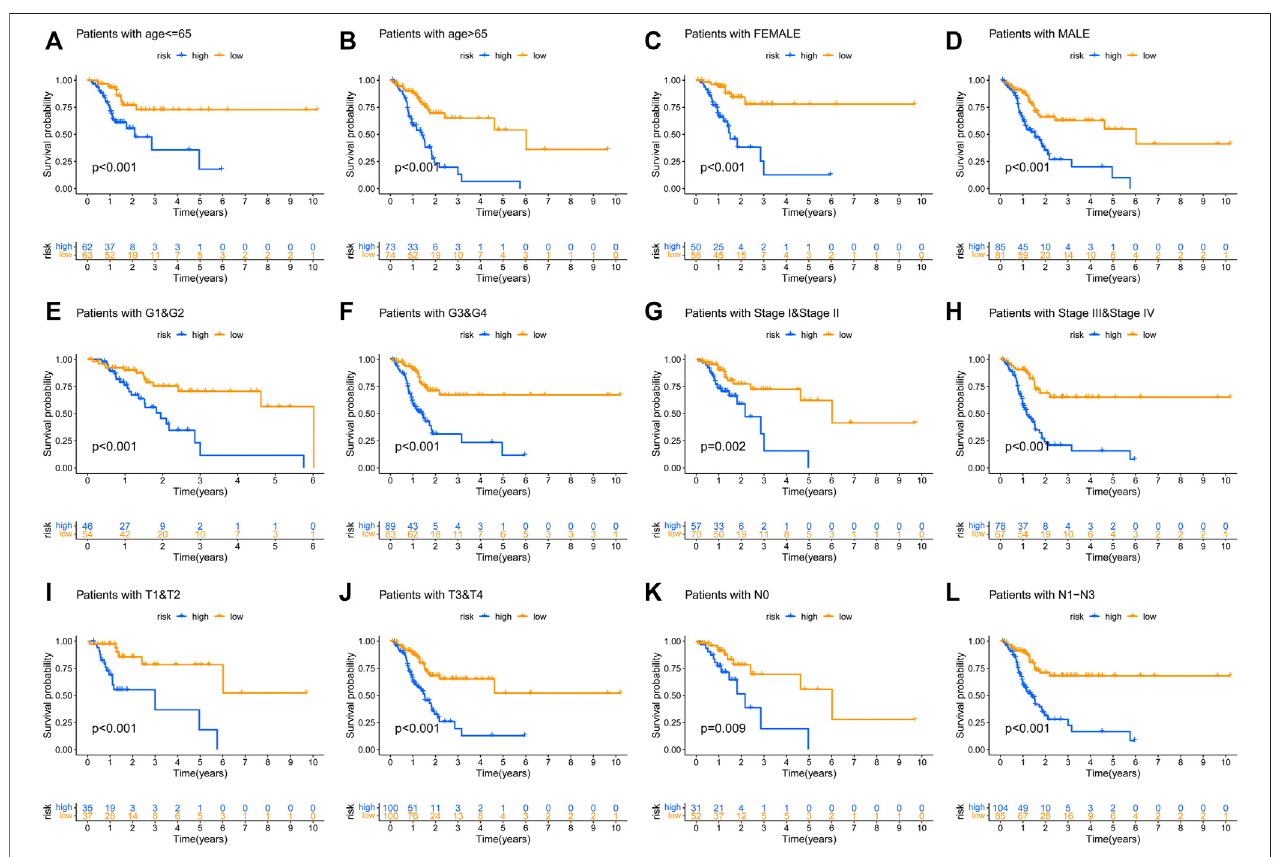
FIGURE 6 | The prognostic function of the risk model in patients with various clinicopathological characteristics was assessed (A – L) .